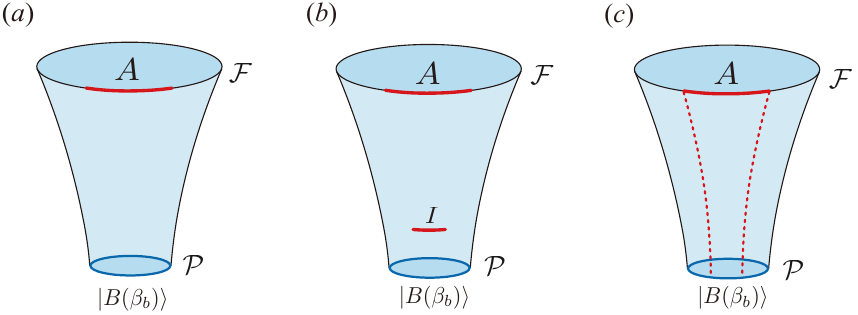
Figure 1 . The spacetime we consider is initiated by an End-of-the-world brane. We consider the matter state prepared by such spacetime, and study its entanglement entropy. The entanglement entropy has three phases. ( a ) Naive thermal entropy phase, computed via effective matter theory. ( b ) The island phase, the entropy is an average of pseudo entropy. ( c ) The boundary phase, the entropy is given by the boundary entropy of the initial